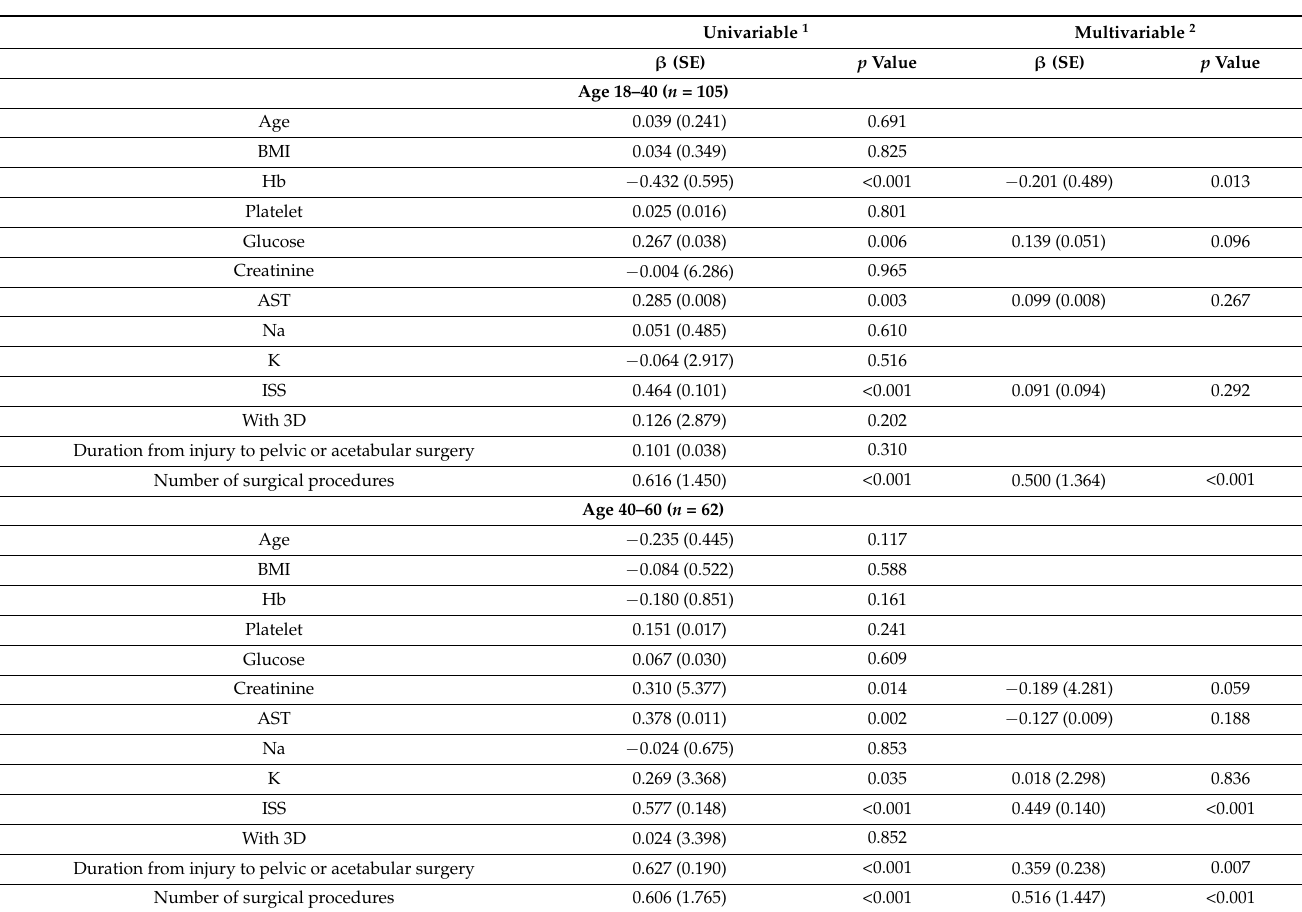
Table 3. Regression coefficients of length of hospital stay on the measurable factors in participants with different age